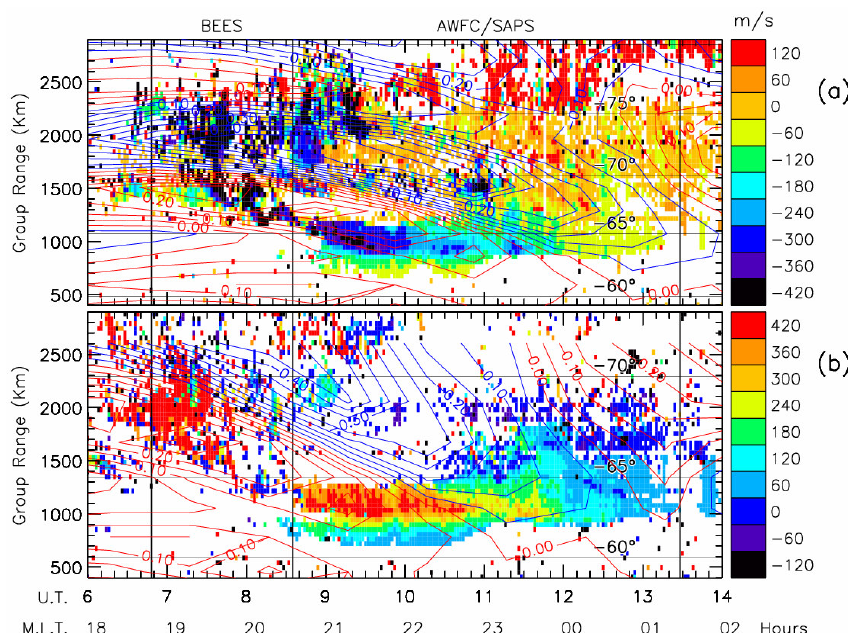
Fig. 9. (a) Range-time plot of the LOS Doppler velocity (ms − 1 ) measured on TIGER beam 0 during 06:00–14:00 UT on 7 April 2001. Thin vertical lines delineate nominal intervals corresponding to the BEES ( ∼ 07:03–08:35 UT) and AWFC ( ∼ 08:35–13:28 UT). The background contours represent the FAC density calculated using Iridium satellite measurements at 09:30 UT (cf. Fig. 7b). The contours were shifted in time to provide a rough indication of the FAC that would be observed on beam 0. (b) The LOS Doppler velocity (ms − 1 ) measured on the TIGER beam 15. Note that the background contours were shifted by a different amount to provide a rough indication of the FAC that would be observed on beam 15. Thin, black, horizontal lines represent magnetic latitudes, and nominal values of MLT above MQI are also given.